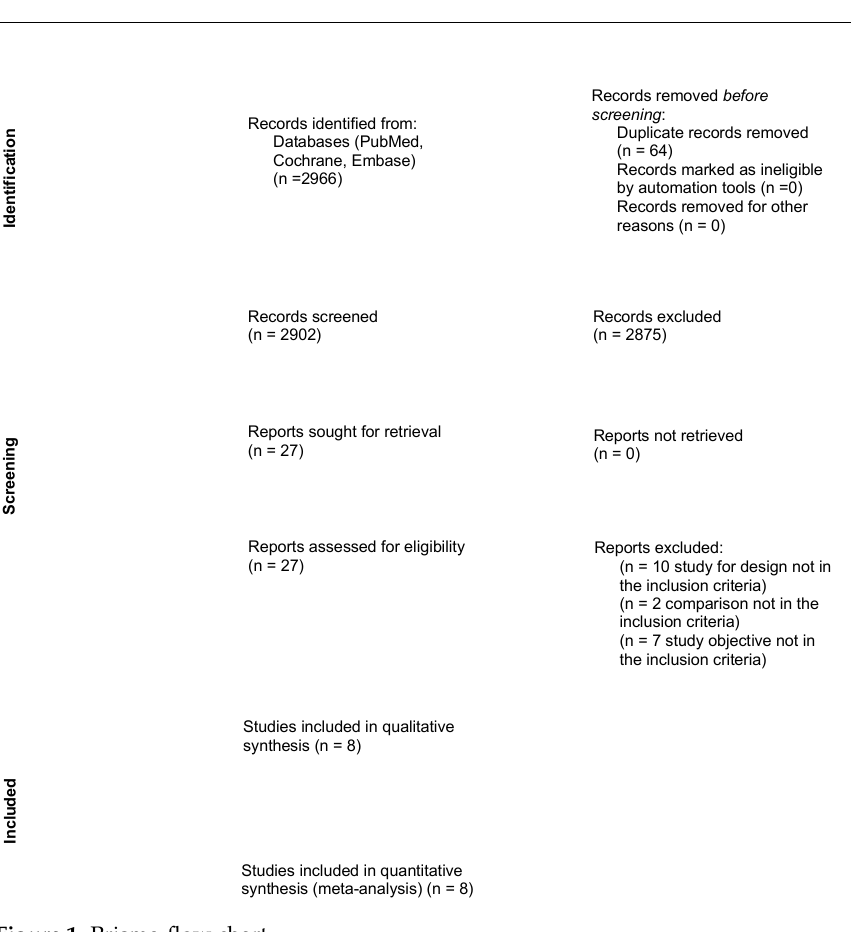
Figure 1. Prisma-flow chart.